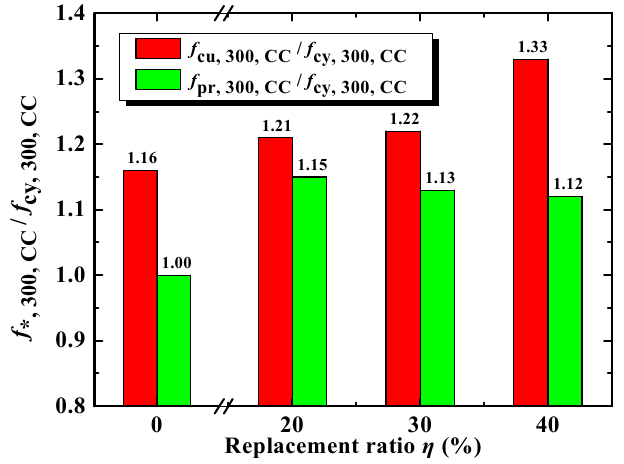
Figure 8. Variation of strength ratio with replacement ratio of DCLs.